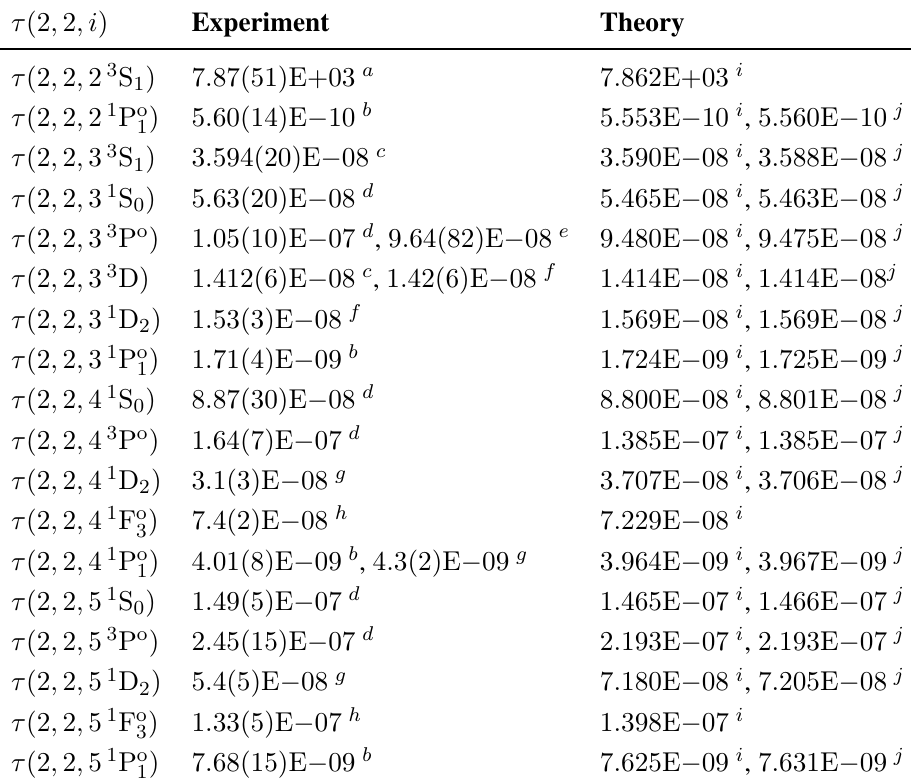
Table 6. Experimental and theoretical lifetimes (s) for states in He I . Experiment: a [133]; b [134]; c [135]; d [136]; e [137]; f [138]; g [139]; h [140]. Theory: i [88]; j [118]. Note: the quantity in brackets gives the experimental